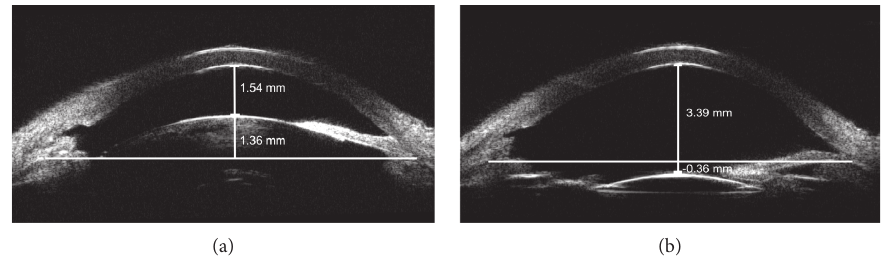
Figure 2: Example of the UBM of a female patient aged 56 years with medically uncontrolled filtered PACG both pre- and posttreatment. (a) Before phacoemulsification and IOL implantation, the ACD and CLR were 1.54 and 1.36mm, respectively. (b) After surgery, the anterior chamber was significantly deepened. The ACD and CLR were 3.39 and − 0.36mm, respectively.